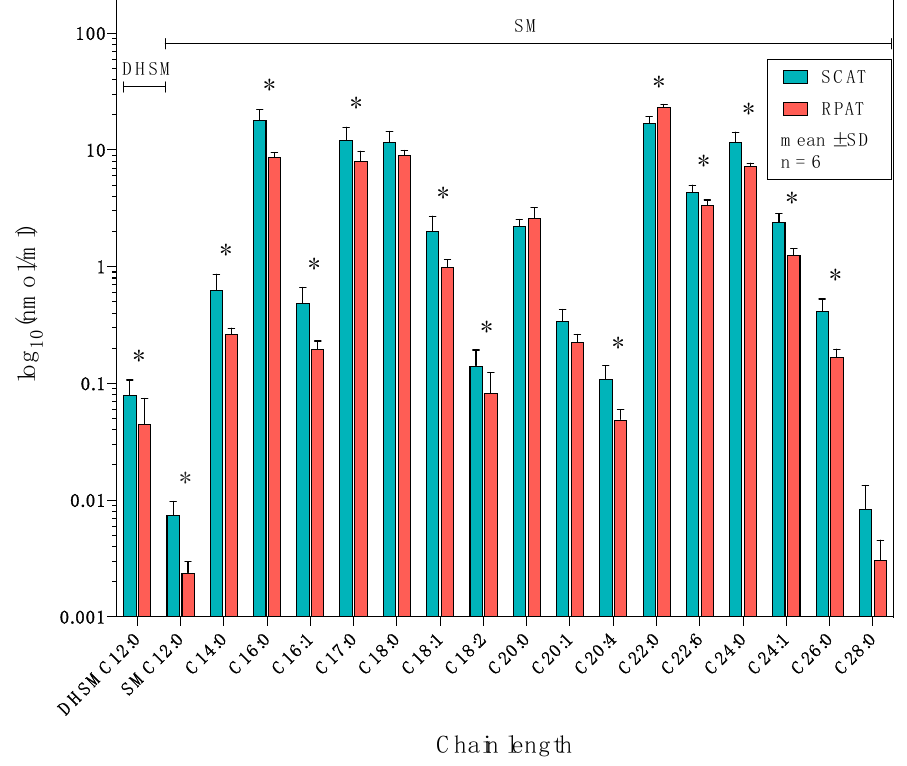
Figure 6. The distribution of dihydroceramide and sphingolipids of the sphingomyelinase pathway in subcutaneous (SCAT) and retroperitoneal adipose tissue (RPAT) in German Holstein bulls ( n = 6). Data are presented as the mean ± standard deviation (SD) on a logarithmic scale. DHSM: dihydrosphingomyelin concentration; SM: sphingomyelin concentration. Asterisks indicate significant differences (* p < 0.05) between two adipose tissues by paired Student’s t -test with FDR correction.